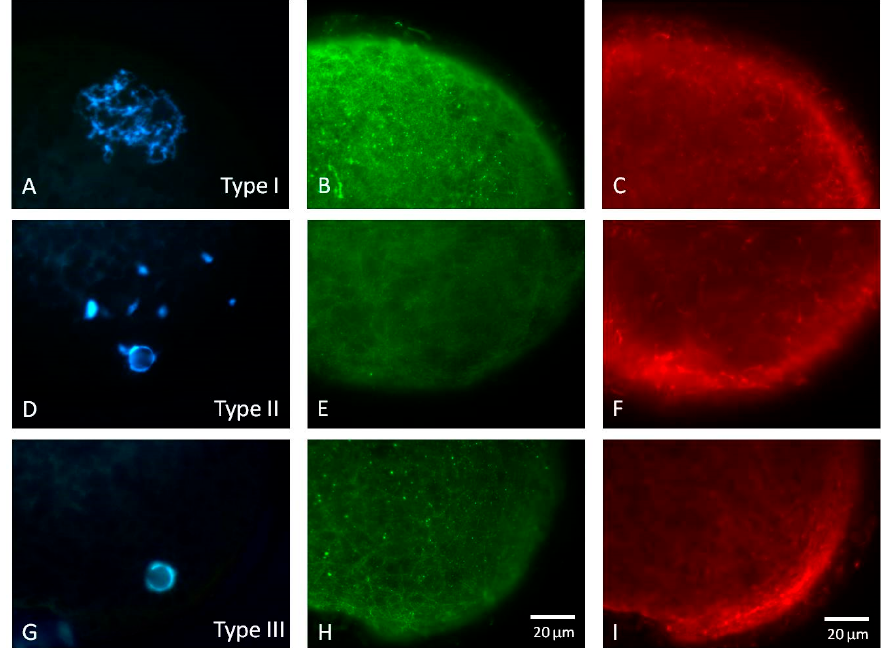
Figure 1. Morphological classification of the chromatin and the cytoskeleton of porcine oocytes at the germinal vesicle stage (GV). In Type I GV oocytes, the most typical configuration of the GV was its chromatin being clearly visible and dispersed in the GV nucleus ( A ). The interphase microtubular network ( B ) and microfilaments ( C ) uniformly spread over the periooplasmic area. The Type II GV oocytes possessed moderately condensed and less dispersed nuclear material. Some perinuclear chromatin structure could be observed ( D ). Ultrastructures of microtubules and microfilaments were similar to those seen in the Type I oocytes ( E , F ). In the Type III GV oocytes, their chromatin displayed single nucleolus-like configuration with only little chromatin material in the GV nucleus ( G ). The periooplasmic microtubules were similar to those in Type I GV ( H ) with no discernible changes in the microfilament pattern ( I ). Scale bar, 20 μ m.